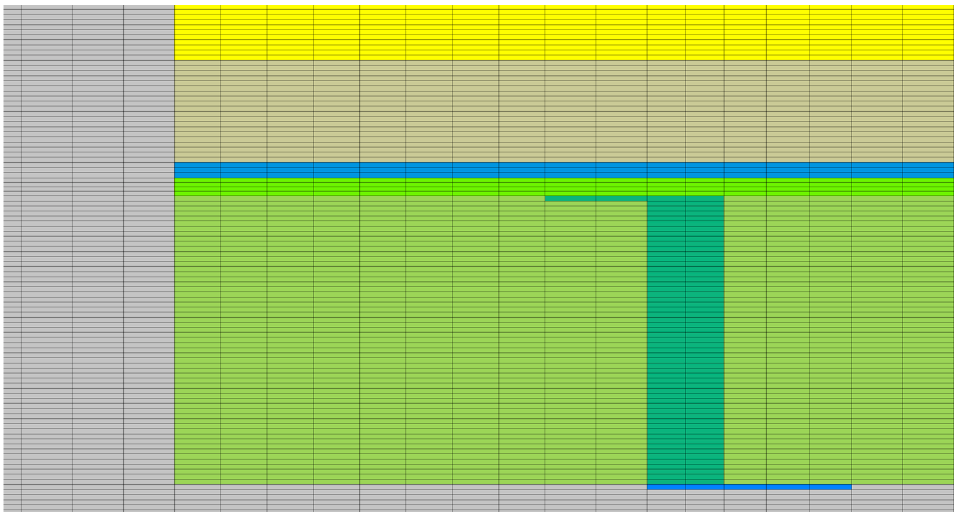
Figure 5. Close-up of mesh of solid structures towards leading edge of reactive foil (Yellow = Si, Brown = Solder, Blue = reactive foil, Green = Green tape ceramics, Turquoise = Temperature probe).